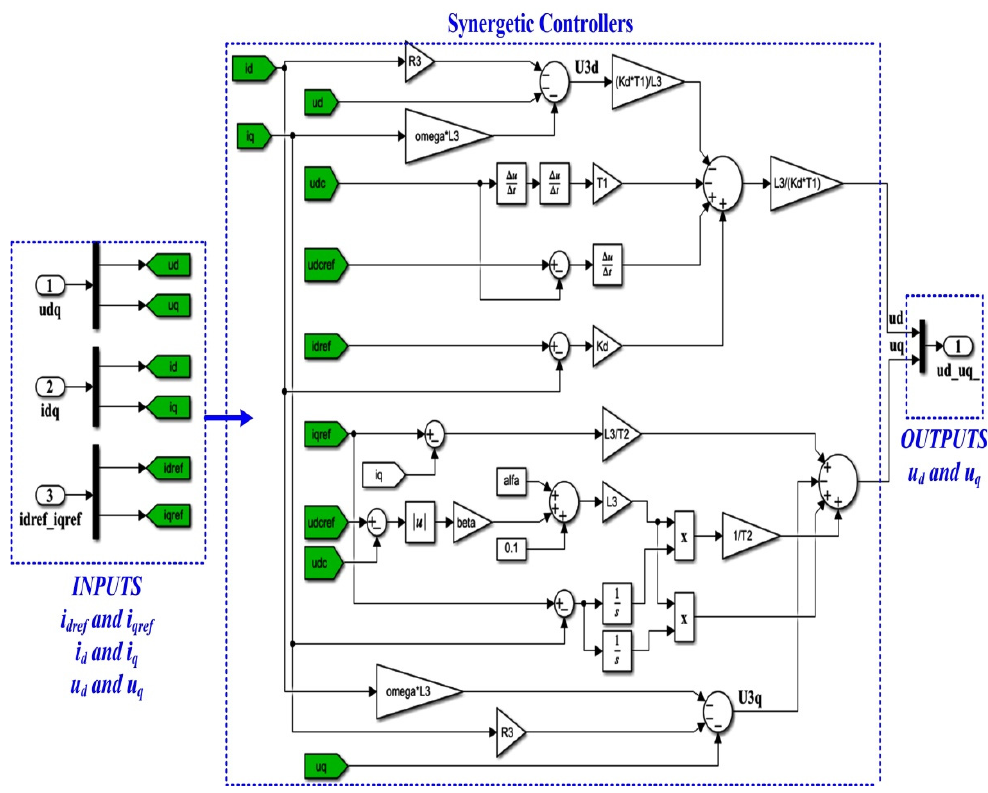
Figure 19. The MATLAB Simulink implementation subsystem for the SYN controller.